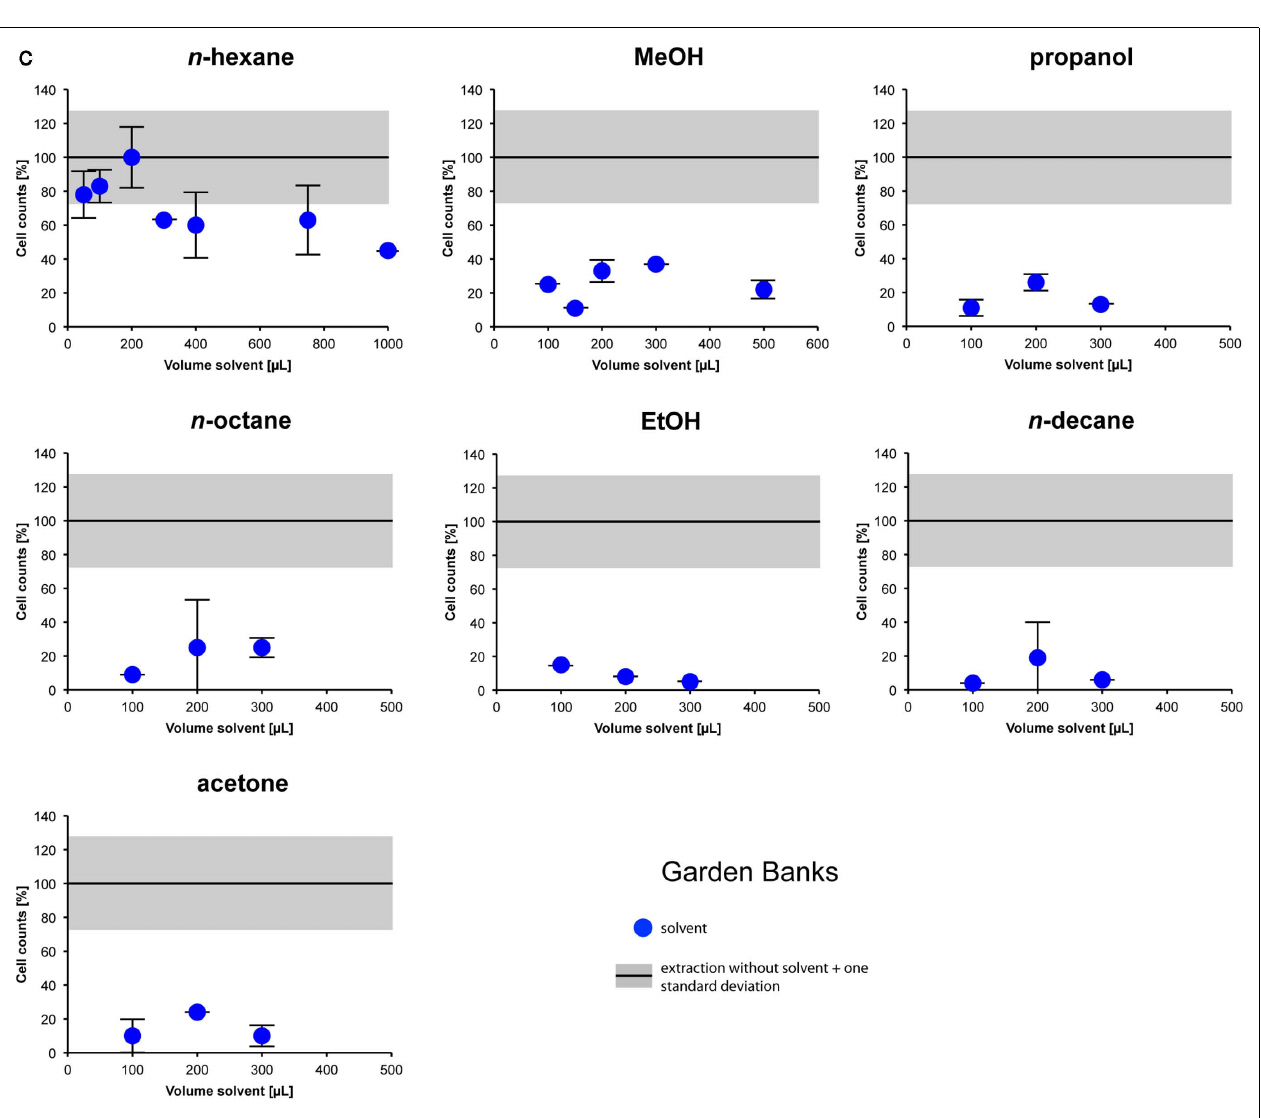
FIGURE 3 | (A) Extraction of hydrocarbons with different solvents applied to a crude oil sand from Athabasca, Canada.To compare the extraction results, cell counts are given as percentages of the results of the standard procedure of Kallmeyer et al. (2008).The obtained cell counts after counting cells from untreated (i.e., without solvent) samples is set to 100%.The shaded areas represent 1 × SD for standard cell extractions without solvent treatment. (B) Extraction of hydrocarbons with different solvents applied to a processed oil sand from Athabasca, Canada.To compare the extraction results, cell counts are given as percentages of the results of the standard procedure of Kallmeyer et al. (2008).The obtained cell counts after counting cells from